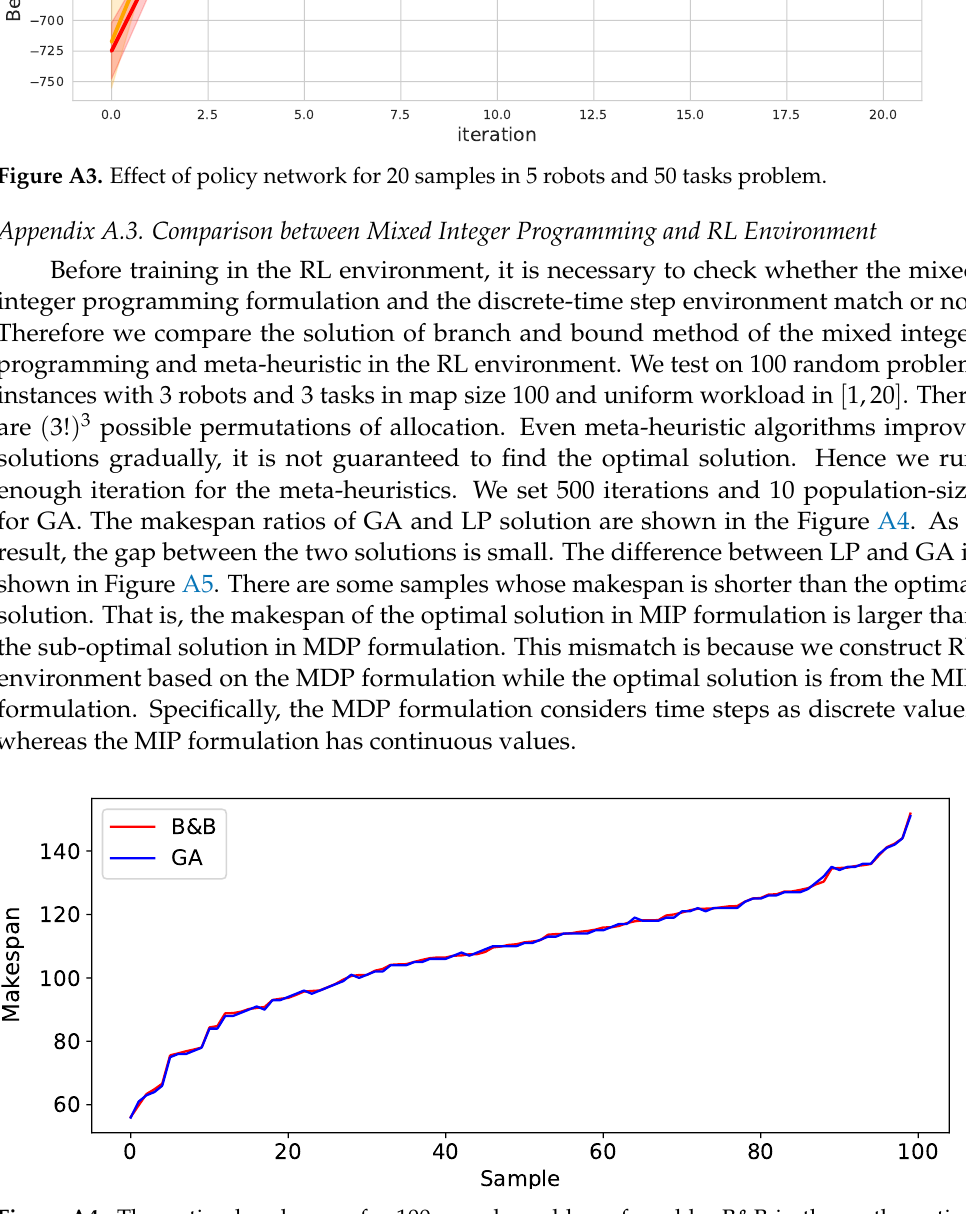
Figure A4. The optimal makespan for 100 sample problems found by B&B in the mathematical formulation and the sub-optimal solution found by GA in the environment of 3 robots and 3 tasks. X -axis represents the index of samples sorted by the B&B